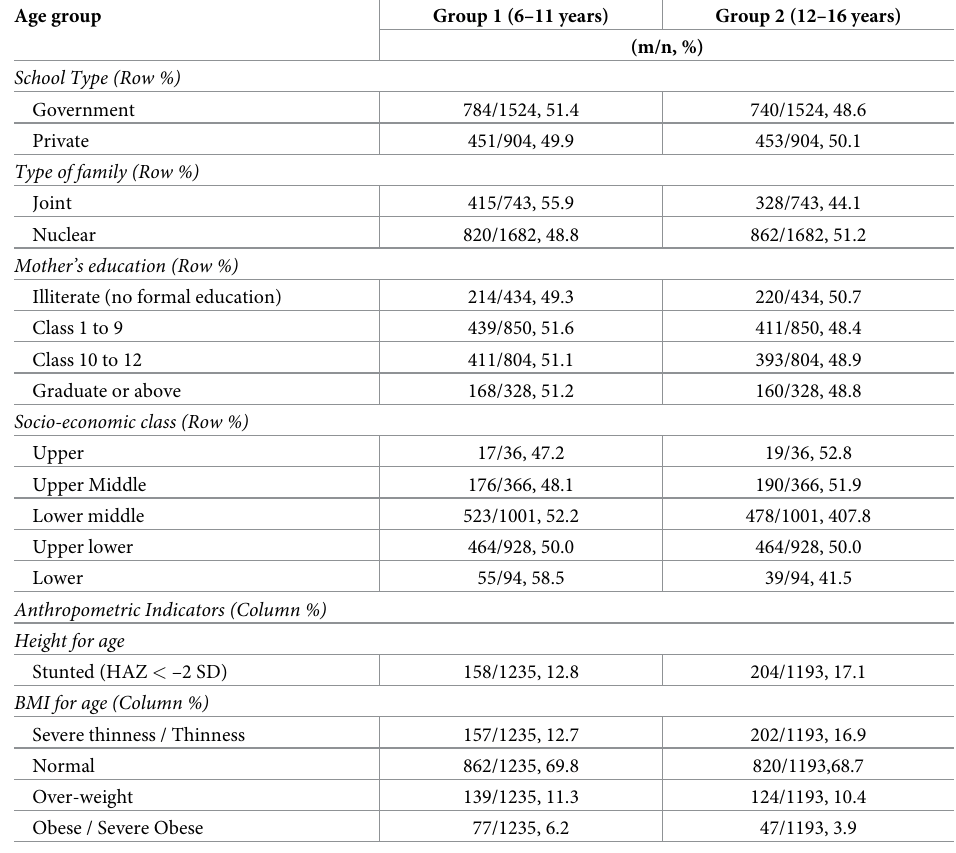
Table 2. Sociodemographic and anthropometric characteristics of study